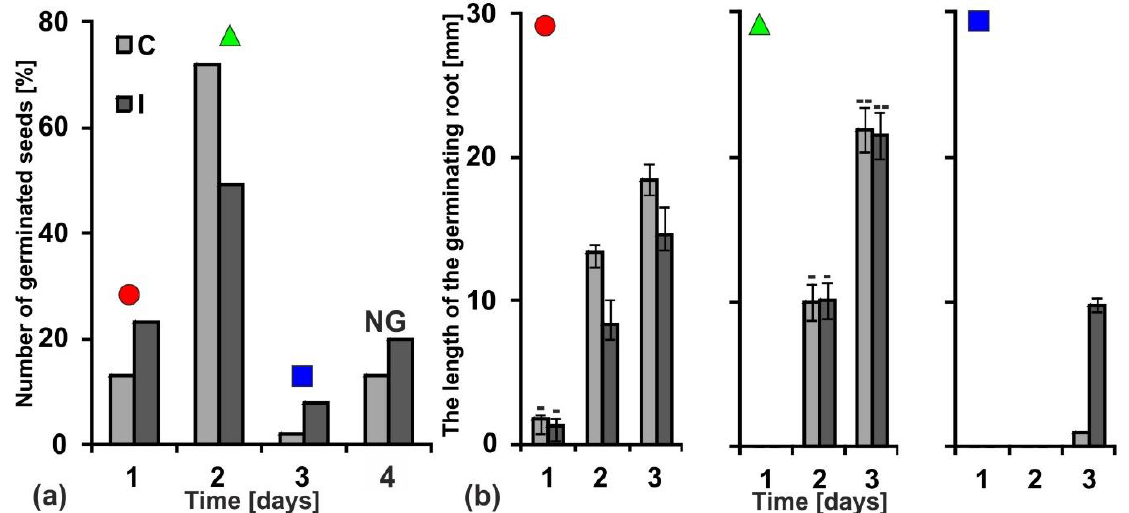
Figure 6. The dynamics of yellow lupine seed germination and growth of embryo roots. ( a ) Percentage of germinated seeds during three days. The seeds collected from not irrigated plants (control C). The seeds collected from irrigated plants (I). The seeds which remained non-germinated (NG) after four days. Black figures (circle, triangle, square) above bars indicate populations of germinated seeds whose root length is presented on the graphs marked with an adequate figure in part (B). ( b ) Dynamics of embryo roots growth during following days of germination. Statistical significance between mean values in diagram marked with black circle and triangle was assessed with the Mann–Whitney U test ( p < 0.01) and the two-way ANOVA with the post-hoc unequal N HSD (honest significant di ff erence) Tukey test ( p < 0.01), respectively. Error bars represent standard deviation (SD). Minuses and double minuses indicate pairs of statistically insignificant results.